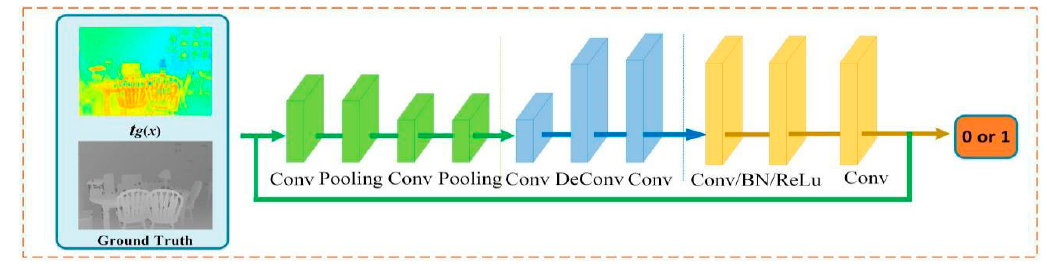
Figure 9. The adversarial networks.